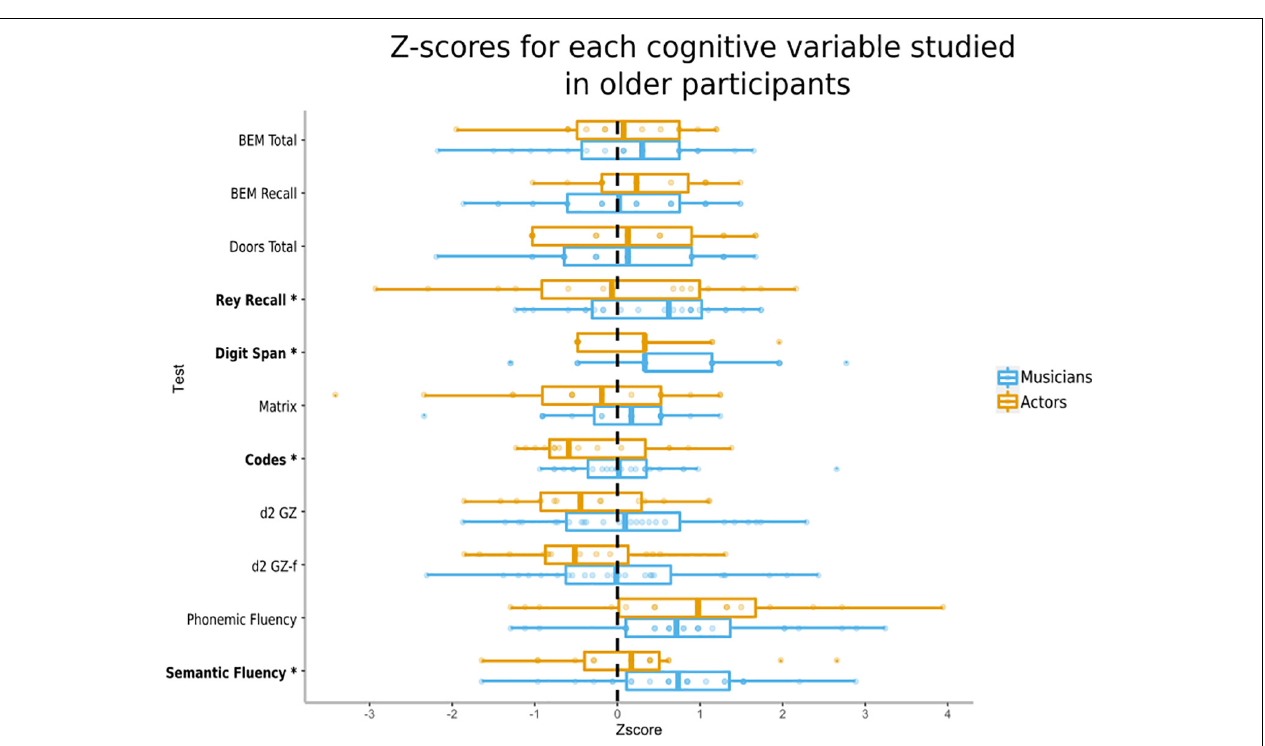
FIGURE 2 | Median, 1st and 3rd quartiles, min and max z -scores of the older participants for each cognitive variable studied. Mean and standard deviation of the control group ( n = 49) serves as reference population for each measure, as such variables were on the same scale with 0 as the mean and 1 as the standard deviation of the control group. The higher the z -score, the better the performance. ( ∗ ) after a test name indicates a significative difference between Controls and Musicians or